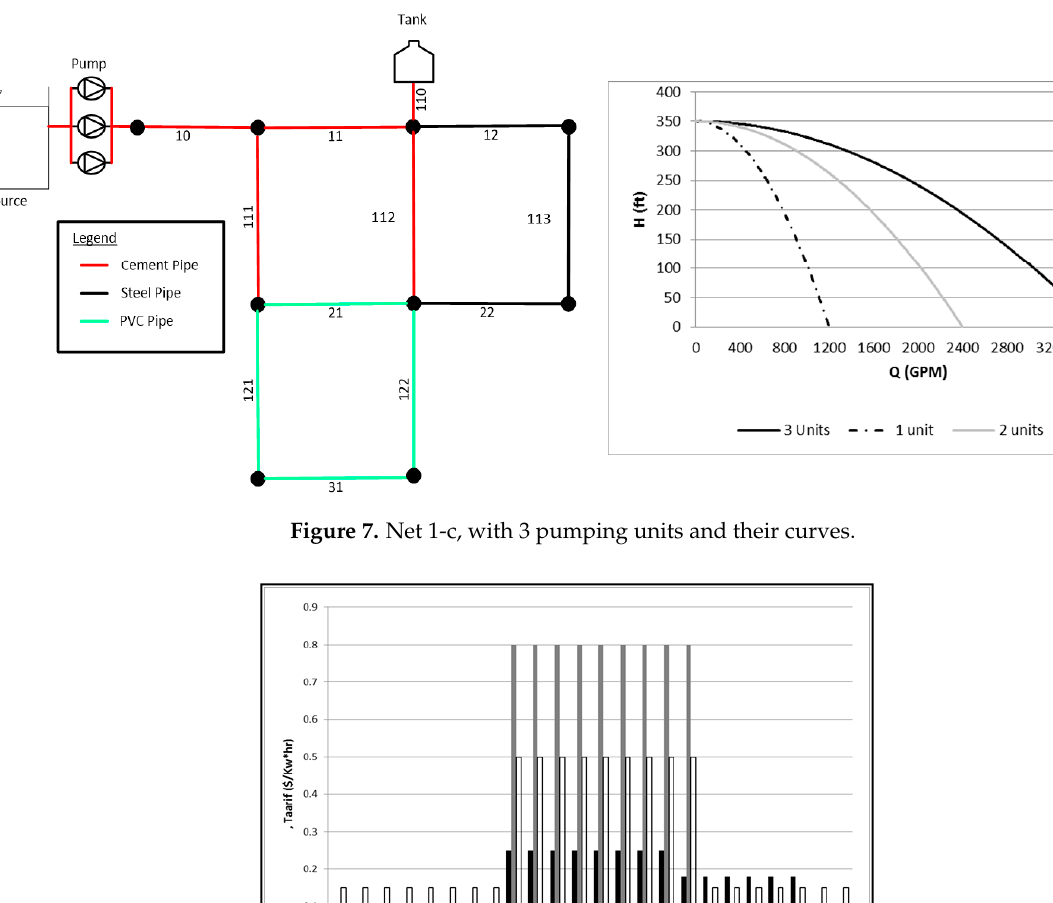
Figure 6. Demand pattern and electricity tariffs for net 1-c.